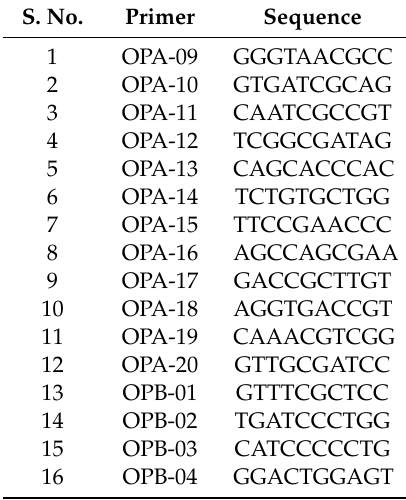
Table 1. The names and sequences of the primers used for random amplified polymorphic DNA (RAPD) analysis. S. No. Primer Sequence 1 OPA-09 GGGTAACGCC OPA-10